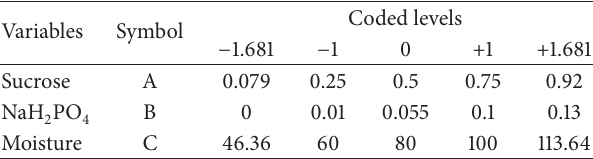
Table 3: Variables and their levels for response surface methodol- ogy.